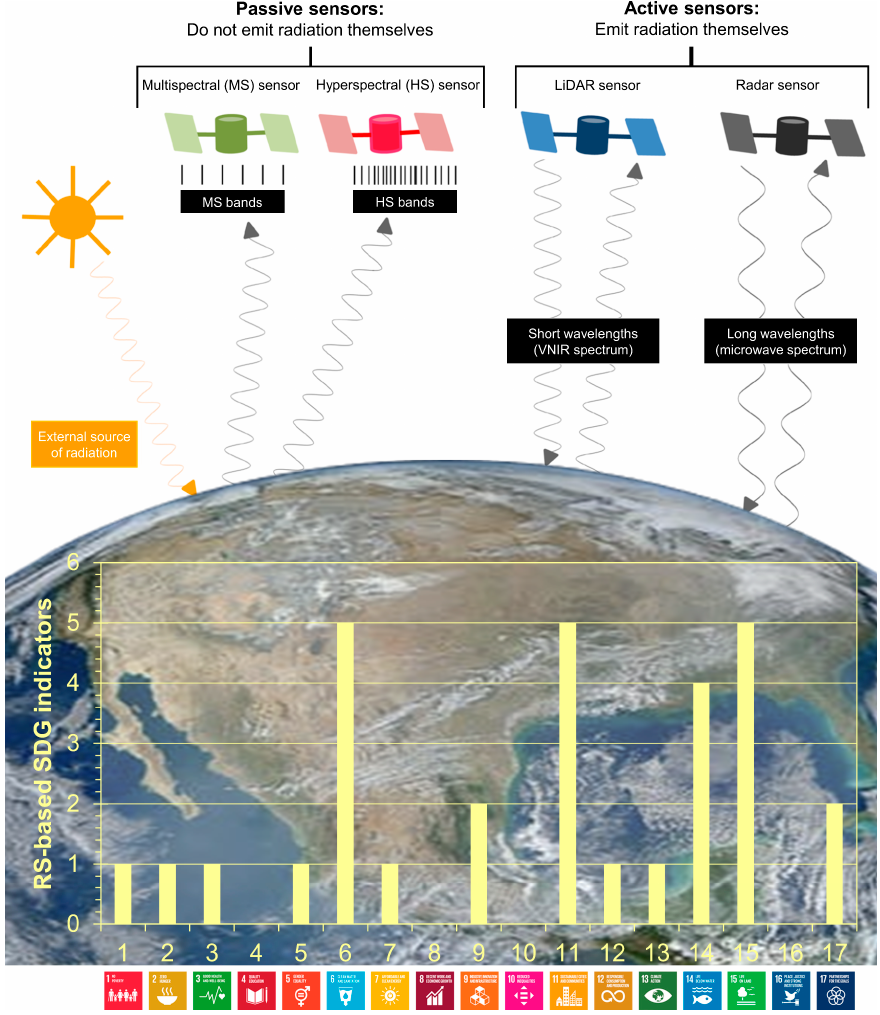
Figure A1. Contributions of RS to SDG monitoring. The diagrams of passive and active remote sensors are from [110]. Passive sensors (e.g., multispectral and hyperspectral sensors) rely on an external source of energy (the sun) and record the radiation reflected by Earth’s surface to produce an image, whereas active sensors (e.g., LiDAR and Radar) emit energy in the microwave part of the electromagnetic spectrum and measure the amount of energy reflected back at them [110]. The column graph shows the number of indicators for each of the 17 SDGs to which Earth Observation data can contribute, directly or indirectly